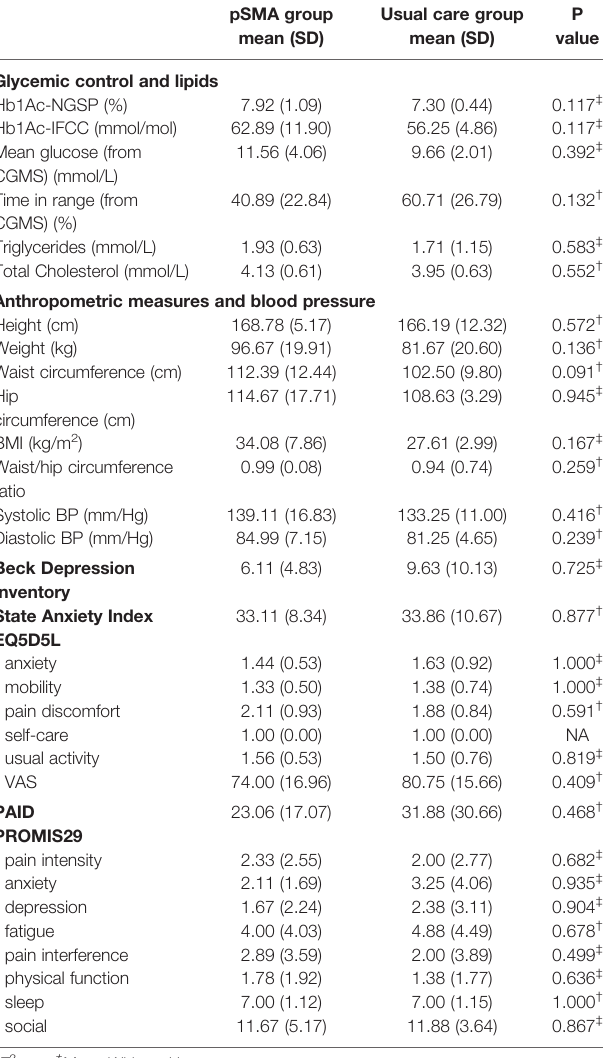
TABLE 1 | Baseline data table.